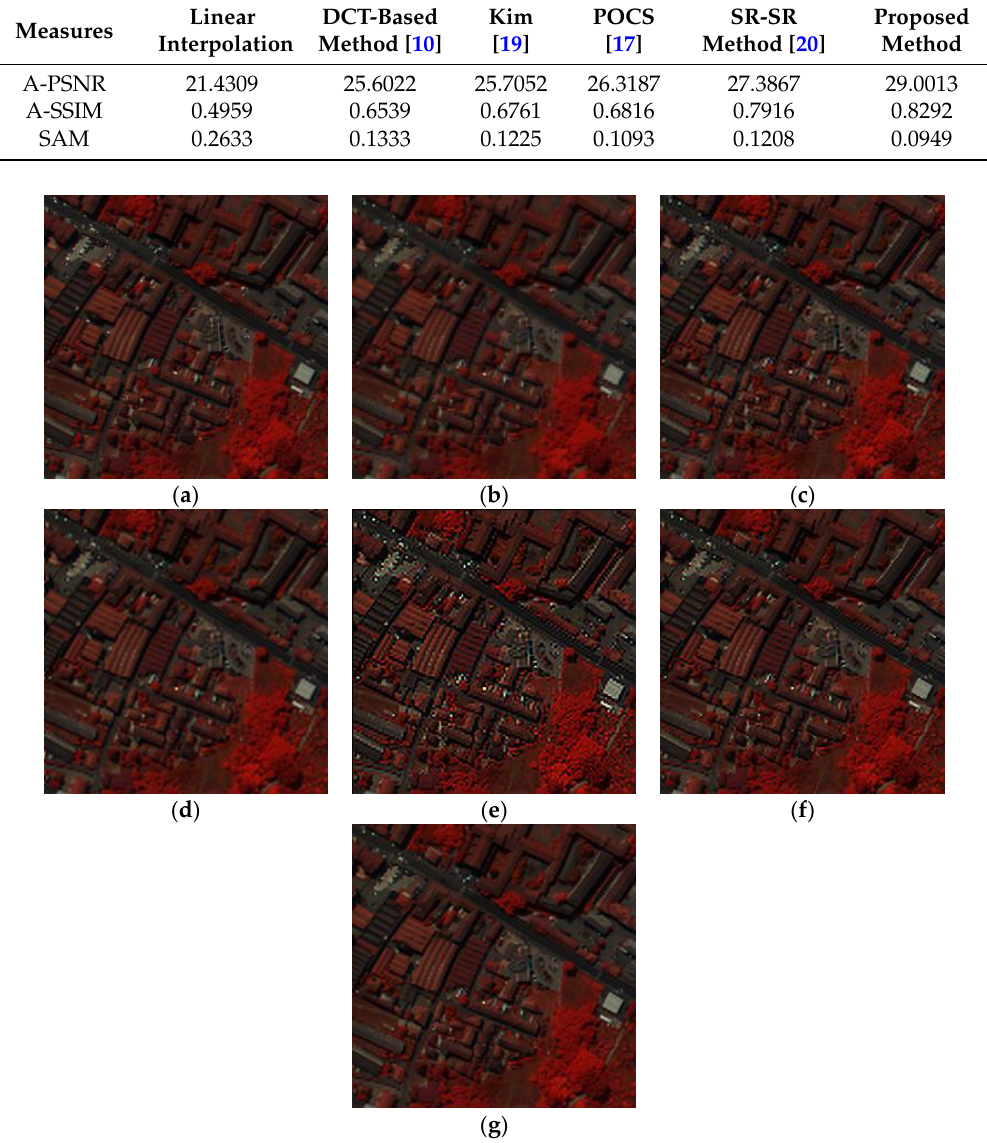
Figure 6. False color image of experimental results for the PaviaC dataset (color composite of R: 80, G: 28, B: 9). ( a ) original HR image; ( b ) linear interpolation results; ( c ) DCT-based method [10] results; ( d ) Kim [19] results; ( e ) POCS [17] results; ( f ) SRSR [20] results; ( g ) proposed APOCS-BM method results.